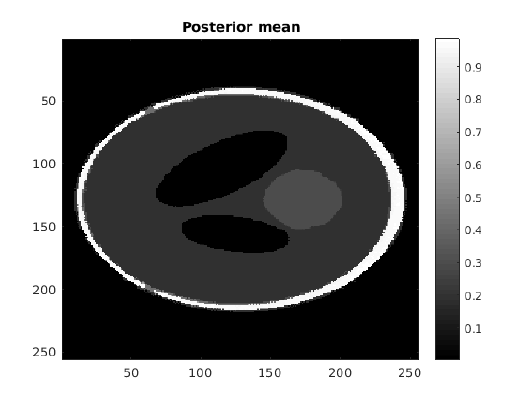
Figure 3. Reconstruction by JMAP.